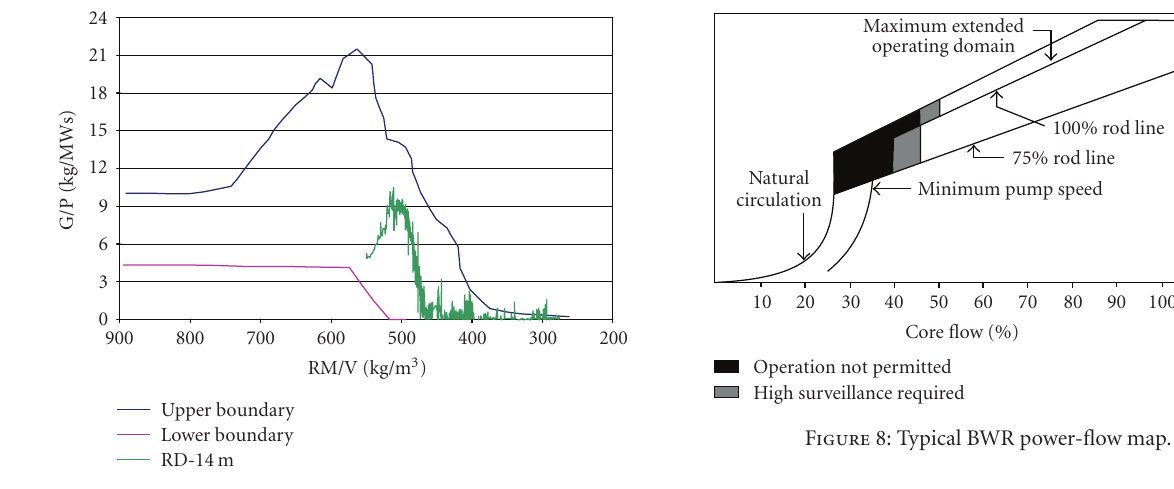
Figure 6: Natural circulation map for the RD-14m calculated data.